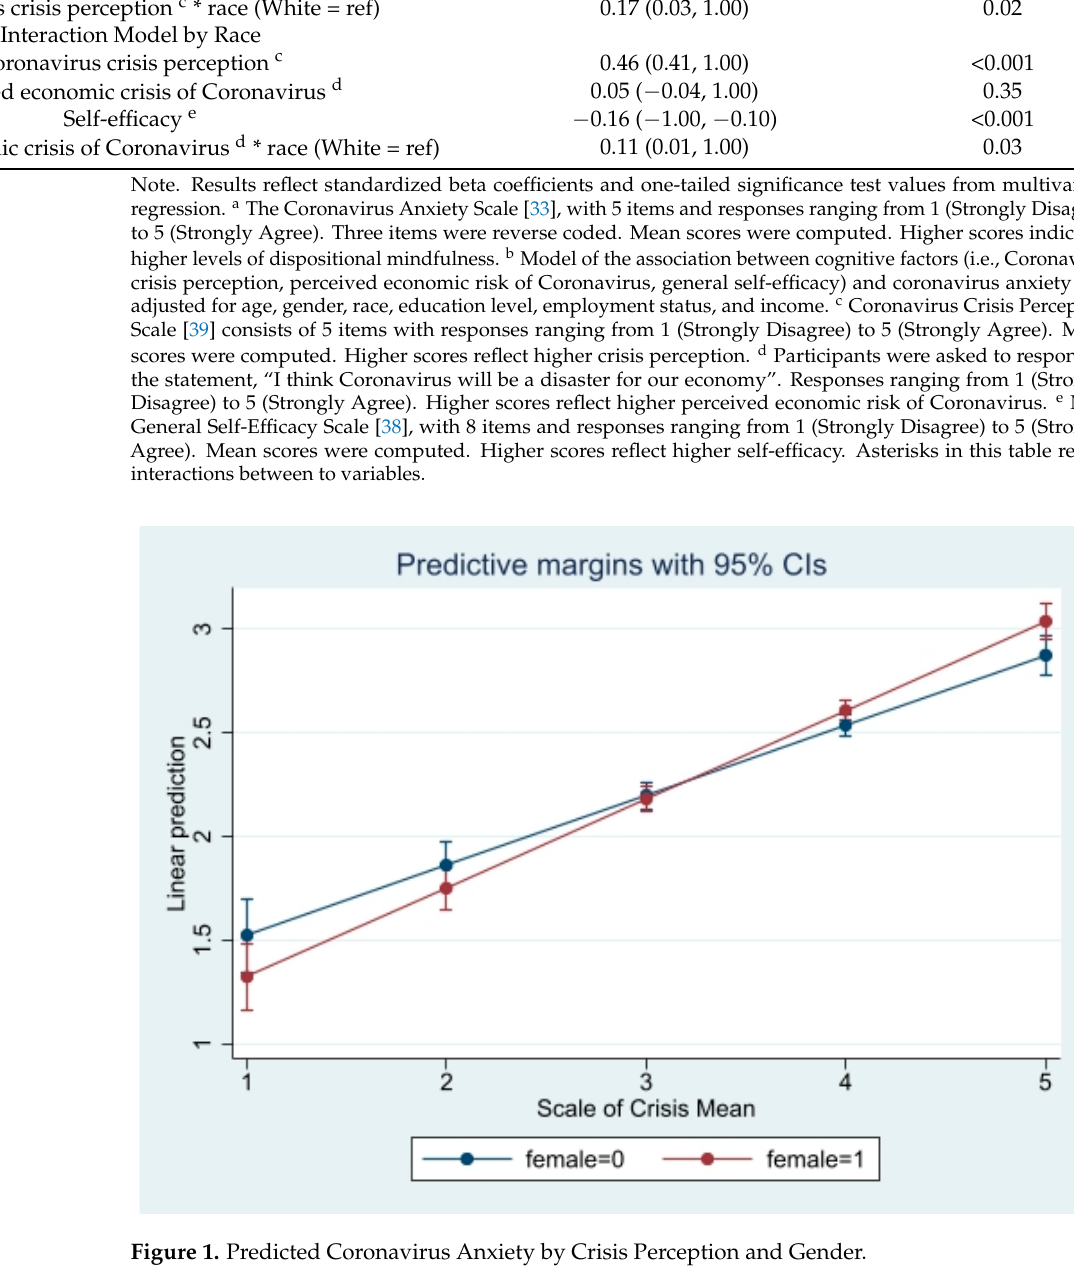
Figure 2. Predicted Coronavirus Anxiety by Crisis Perception and Race .